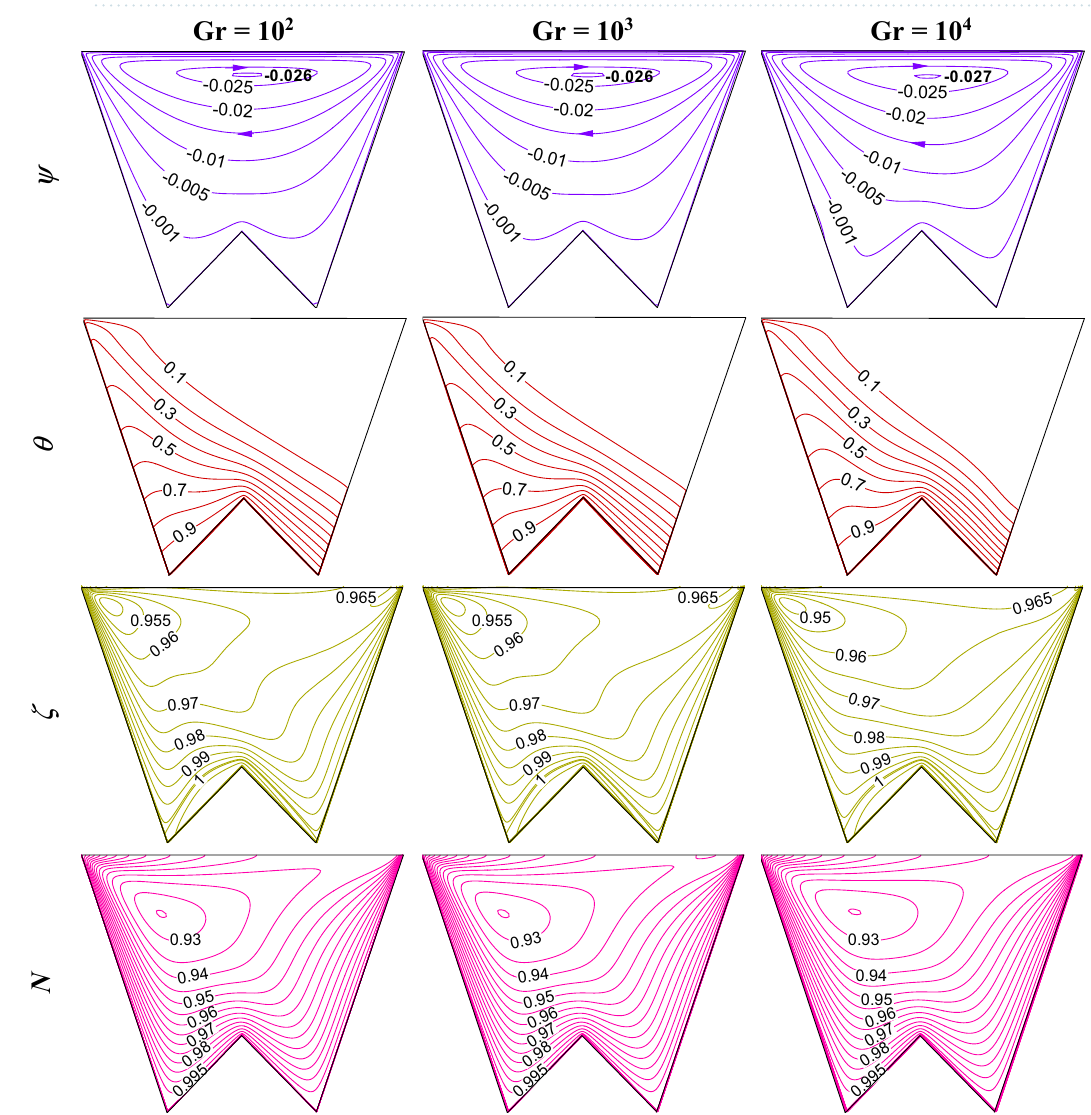
Figure 22. Impact of Grashof number (Gr) on the flow structure (first-row), temperature (second-row), oxygen (third-row), and isoconcentration of microorganisms (fourth-row) when R b = 50, Le = Pe = 1, Da = 10 –3 , Ha = 50, m = 1, δ = 0.3, γ =